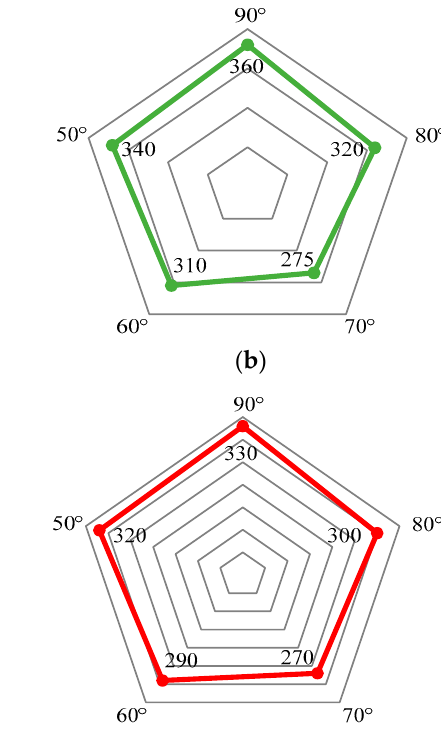
( f ) Figure 14. Numerical simulation schemes for different cutting heights. ( a ) Cutting height 3 m; ( b ) Cutting height 4 m; ( c ) Cutting height 6 m; ( d ) Cutting height 7 m; ( e ) Cutting height 8 m; ( f ) Cutting height 9 m.